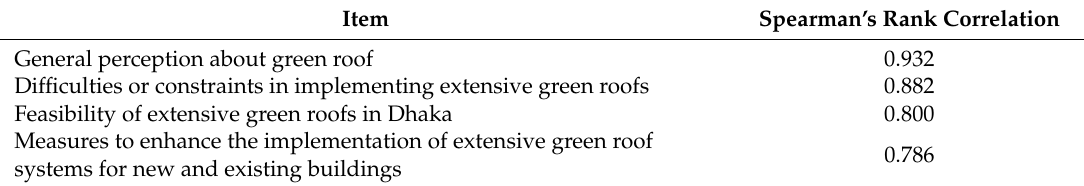
Table 9. Spearman’s rank correlation between the respondents involved and not involved in green roof